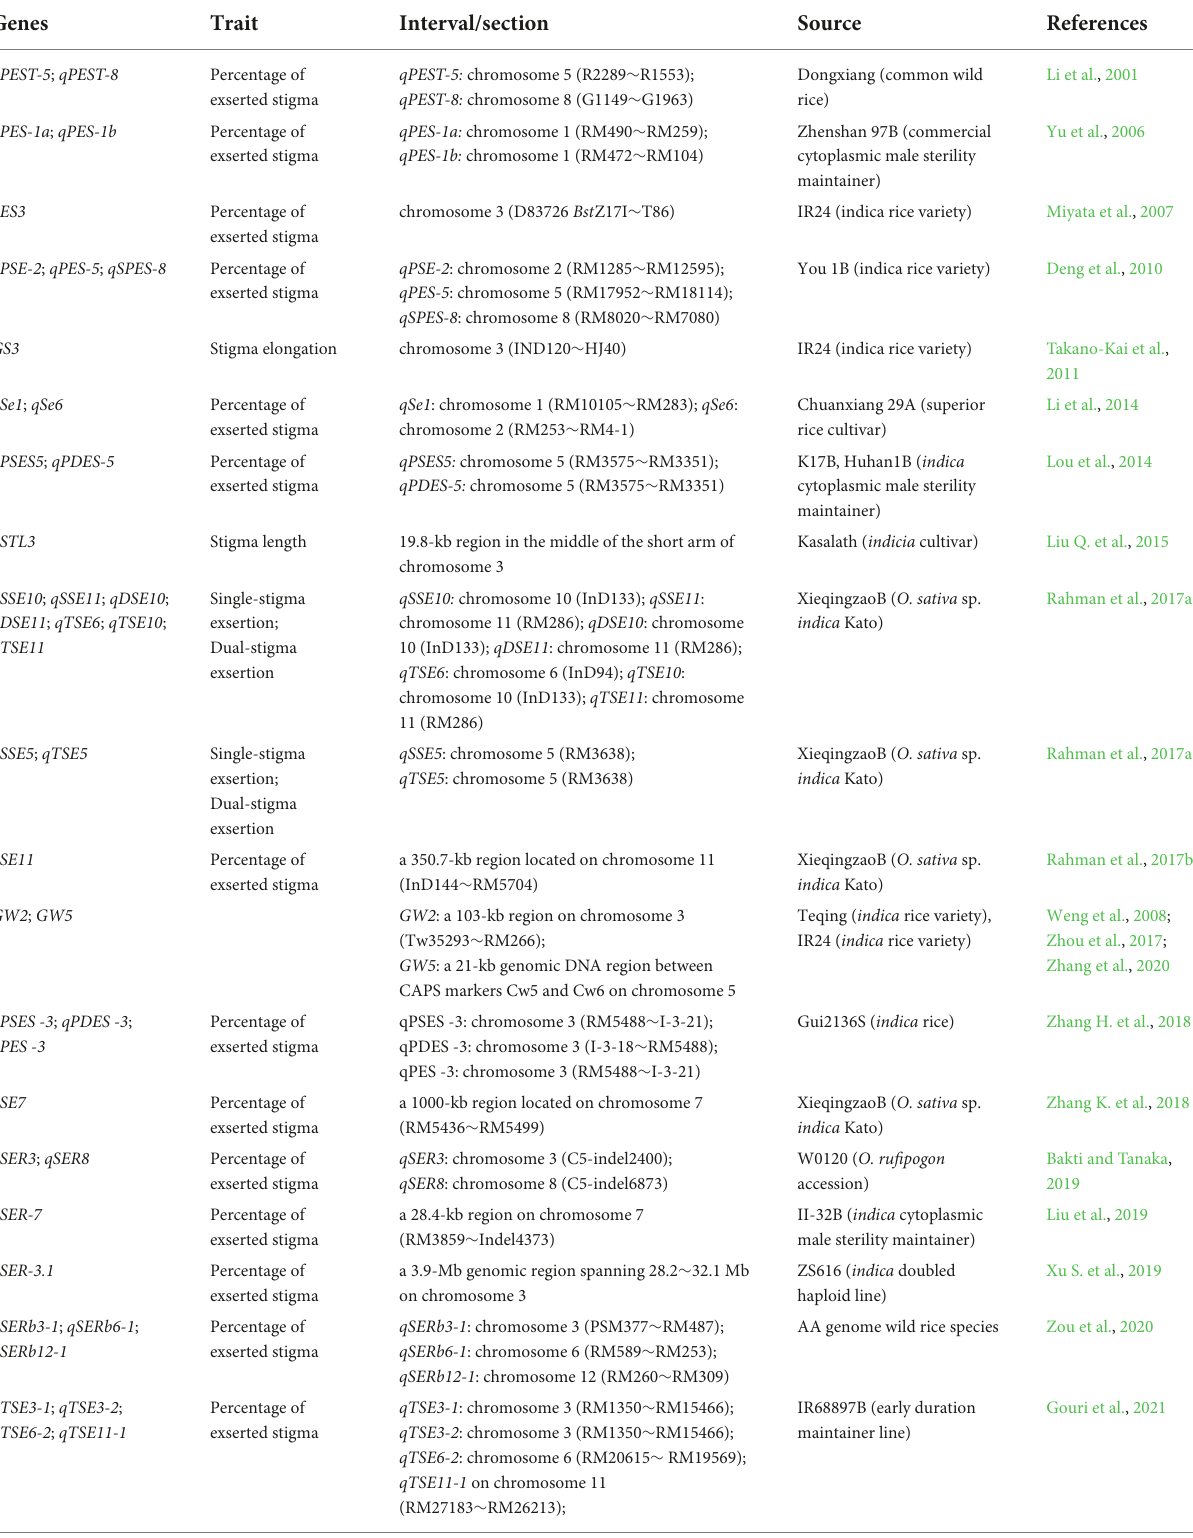
TABLE 2 Genes controlling stigma exsertion in